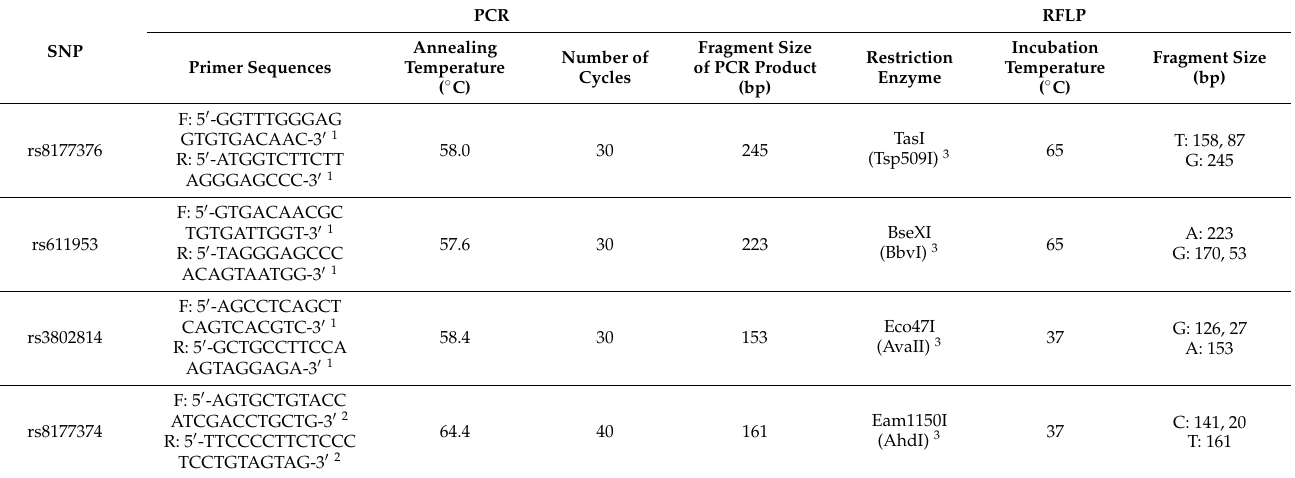
Table 1. Reaction conditions for PCR-RFLP